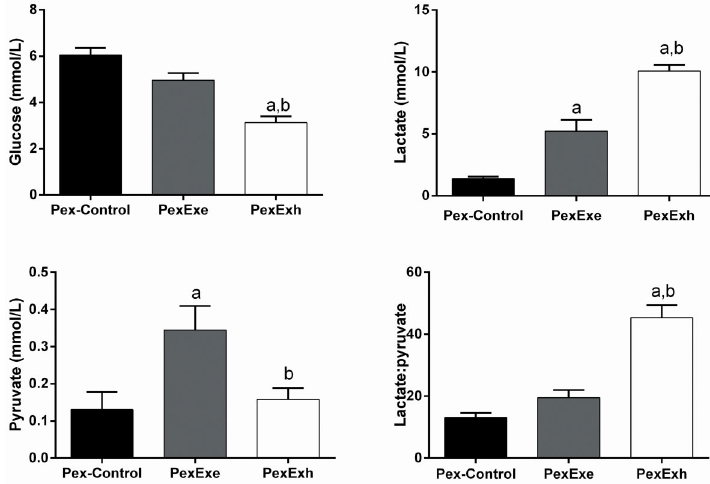
Figure 3. Plasma metabolite measurements in the pre-exposed (Pex) group. Effect of an acute strenuous swimming session on plasma glucose, lactate, pyruvate concentrations, and the lactate:pyruvate ratio in overnight fasted rats. Two rats were placed in the water tank on the last day of the pre-exposed protocol. The fi rst rat swam for 15 min (PexExe) and the second rat swam until exhaustion (PexExh). The control rats (Pex-Control) were placed in the water tank and immediately removed. Data reported as means ± SE (n=5 – 6 animals per group). a P o 0.05 compared with the Pex-Control; b P o 0.05 compared with the PexEx group (one-way ANOVA with the Tukey test for post hoc comparisons).